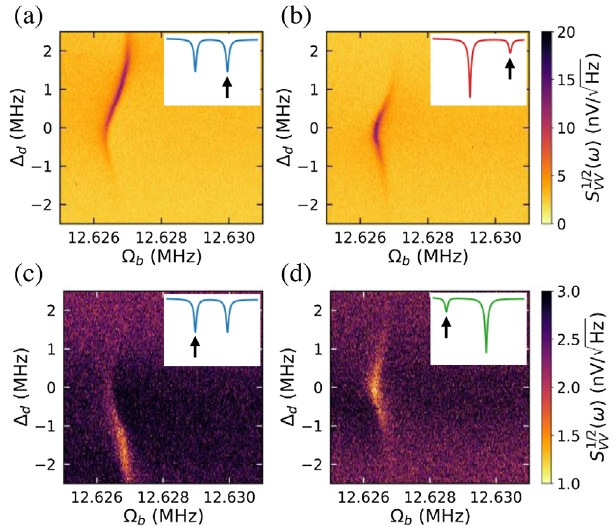
FIG. 9. Mechanical spectrum. (a) – (d) Mechanical power spec- tral density. Detuning is relative to the specific mode shown within the inset. In plots (a) and (c) the probe power is held constant at 0.54 mW. In plots (b) and (d) the probe power is held constant at 0.27 mW. All data presented were obtained with the experimental setup in atmospheric